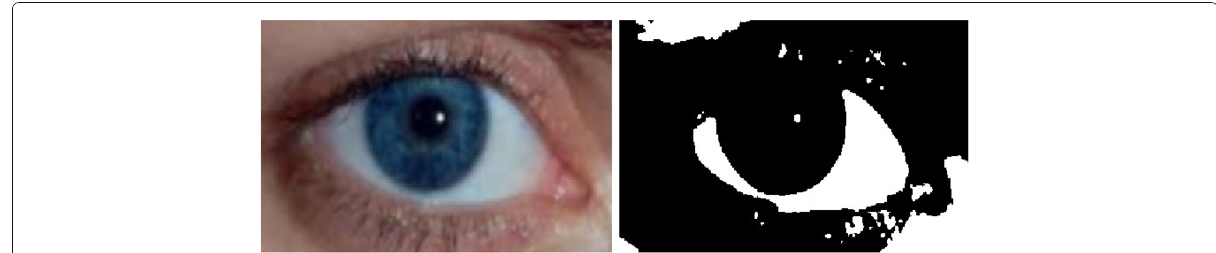
Fig. 5 Detection of the white of the eye area in the designation of the lower eyelid edge